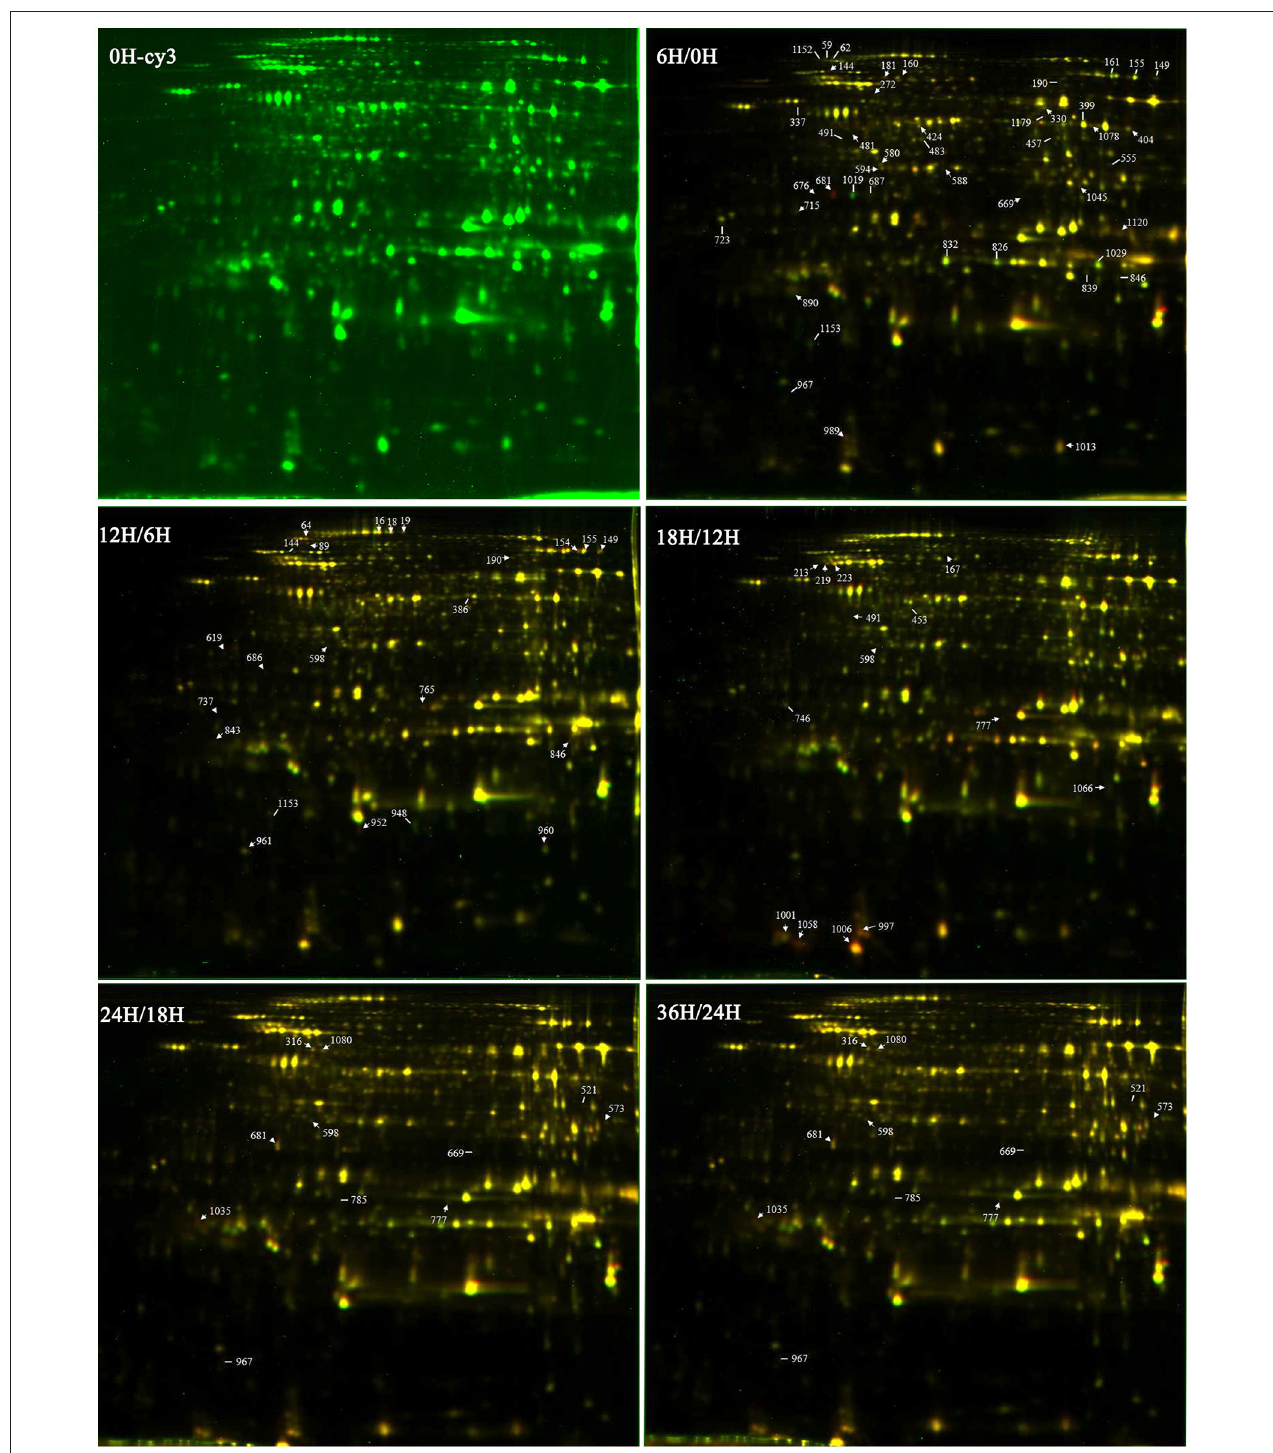
FIGURE 3 | The 2-DIGE maps of different germination stages. 0H-cy3 represents the sample labeled with cy3. 6H/0H, 12H/6H, 18H/12H, 24H/18H, and 36H/24H represent comparisons between two samples.